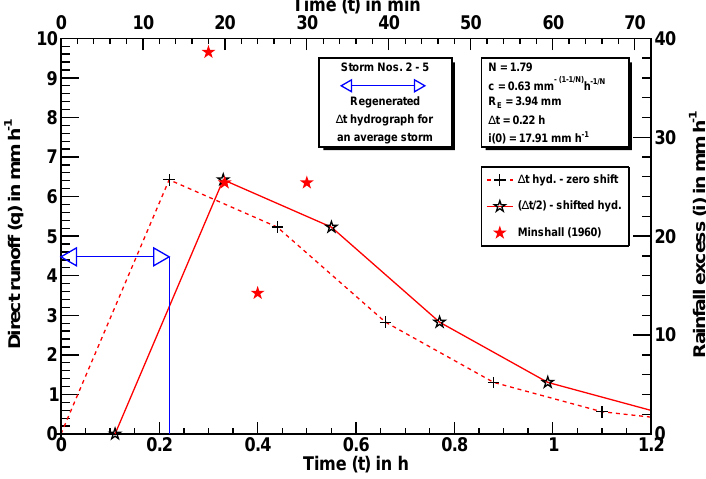
Fig. 6b. Same as Fig. 6b, except the 1t hydrograph is computed by the inverse Bakhmeteff function method of convolution. from 1t /2 to 1t /(14 × 60), i.e. 7 min to 1 sec, the